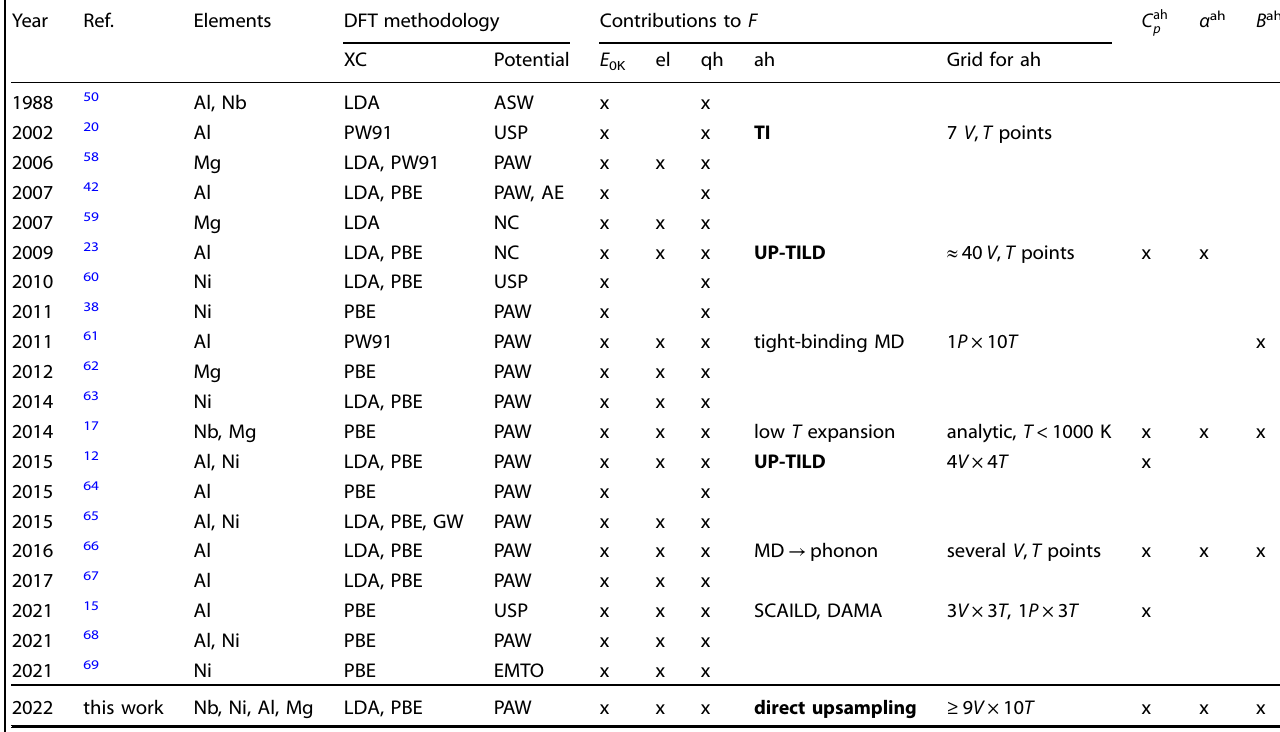
The corresponding exchange-correlation (XC) functionals and the potentials representing the core electrons are listed. The columns under “ Contributions to F ” indicate which terms (0K static energy “ E 0K ” , electronic “ el ” , quasiharmonic “ qh ” and anharmonic “ ah ” ) were included in the total free energy. For works that included the anharmonic contribution, the number of volume V (or pressure P ) and temperature T data points is mentioned. Studies including the explicit anharmonic contribution up to all orders and to the accuracy of DFTare printed in boldface. All of the used abbreviations are expanded in the Supplementary